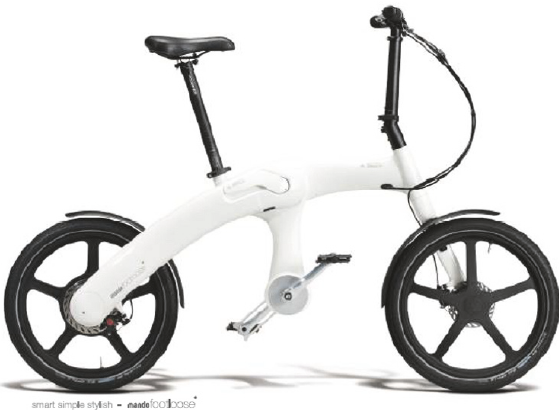
Figure 1: Mando Footloose E-Bike (taken from mando).